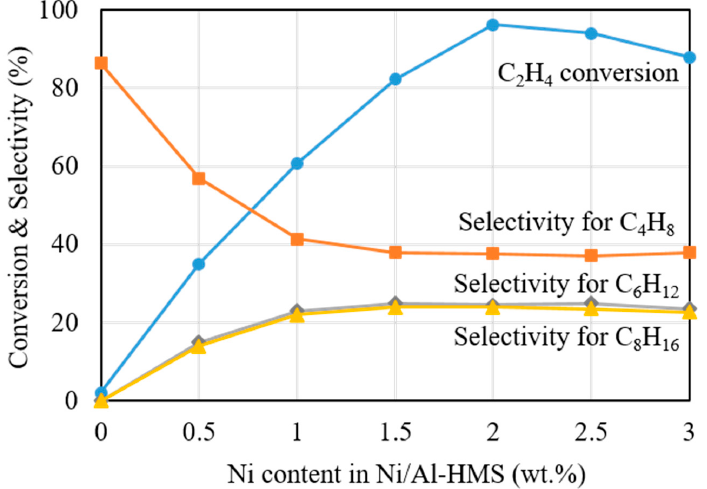
Figure 4. Dependence of Ni content in Ni/Al-HMS for the oligomerization of ethylene. Reaction conditions: same as those listed in Table 1.